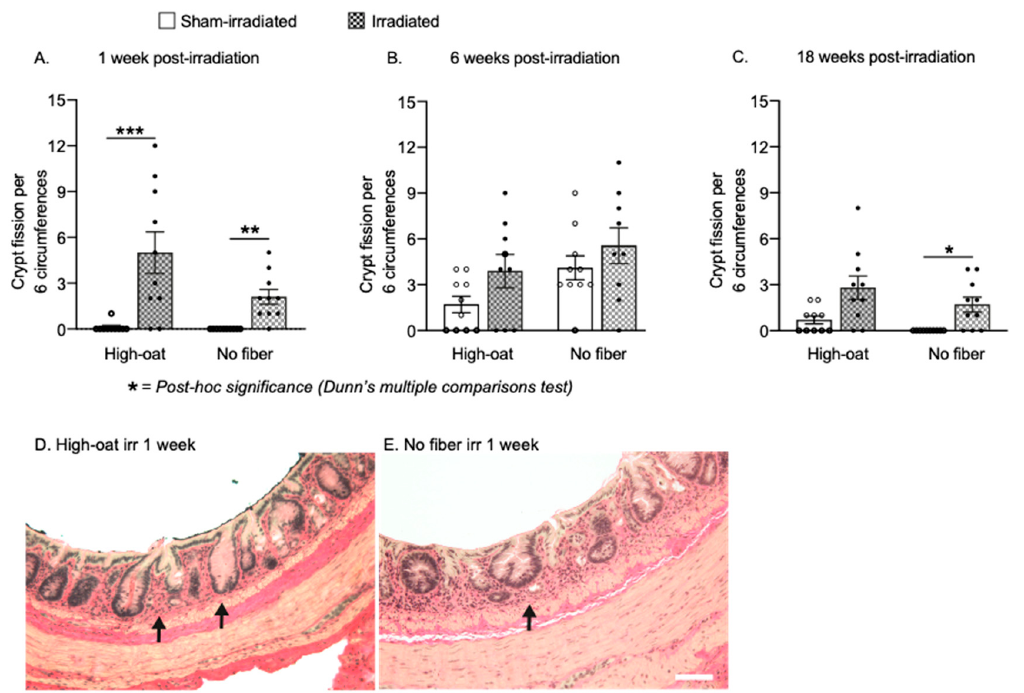
Figure 3. Number of crypt fissions per six circumferences at 1 week, 6 weeks and 18 weeks after irradiation. ( A ). An increase in the number of crypt fissions was observed in both the diet groups one week after irradiation, with a more pronounced increase in the High-oat group. *** p = 0.001 and ** p = 0.0034. ( B ). At six weeks, there was slight, but not statistically significant increase in the number of crypt fissions in both irradiated diet groups, and more crypt fissions in the animals fed the No-fiber diet. Both control groups had a higher baseline than the control groups at 1 and 18 weeks. ( C ). At 18 weeks, there were still more crypt fissions in the irradiated mice of both diet groups compared to the sham-irradiated mice. * p = 0.0157. ( D , E ). Micrographs (40× magnification) of colorectal mucosa stained with Verhoeff’s Elastic Stain. Arrows depict examples of crypt fissions. Data are shown as mean ± S.E.M.